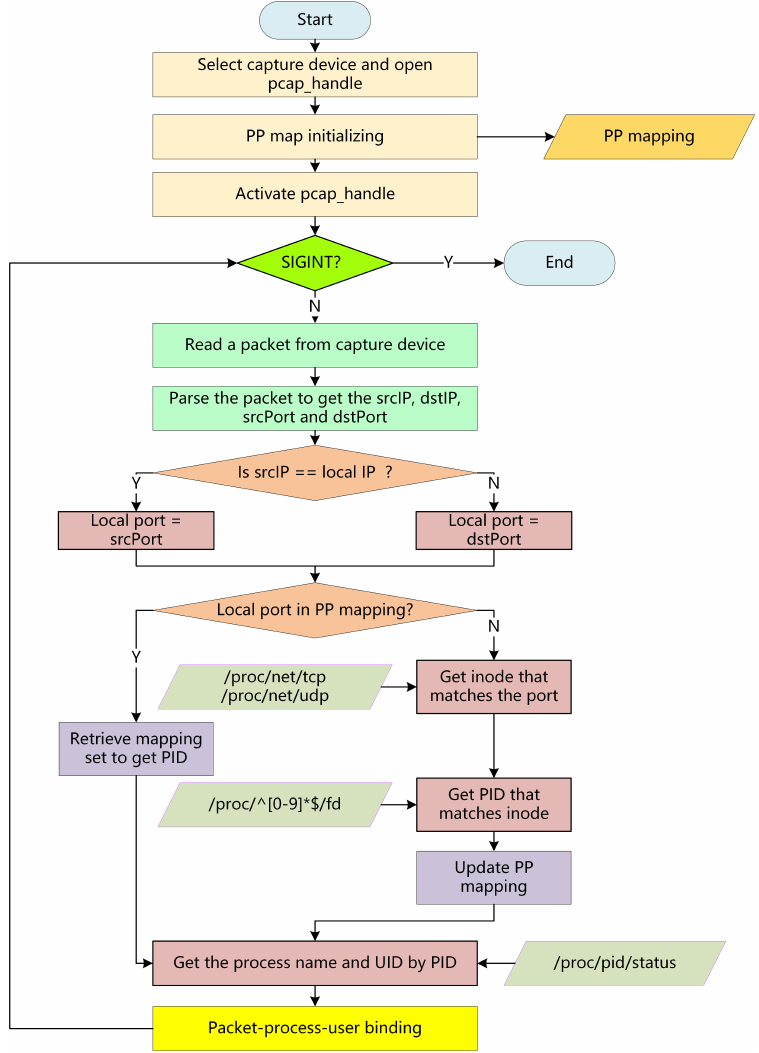
Figure 5. A3C-Linux sample collection and